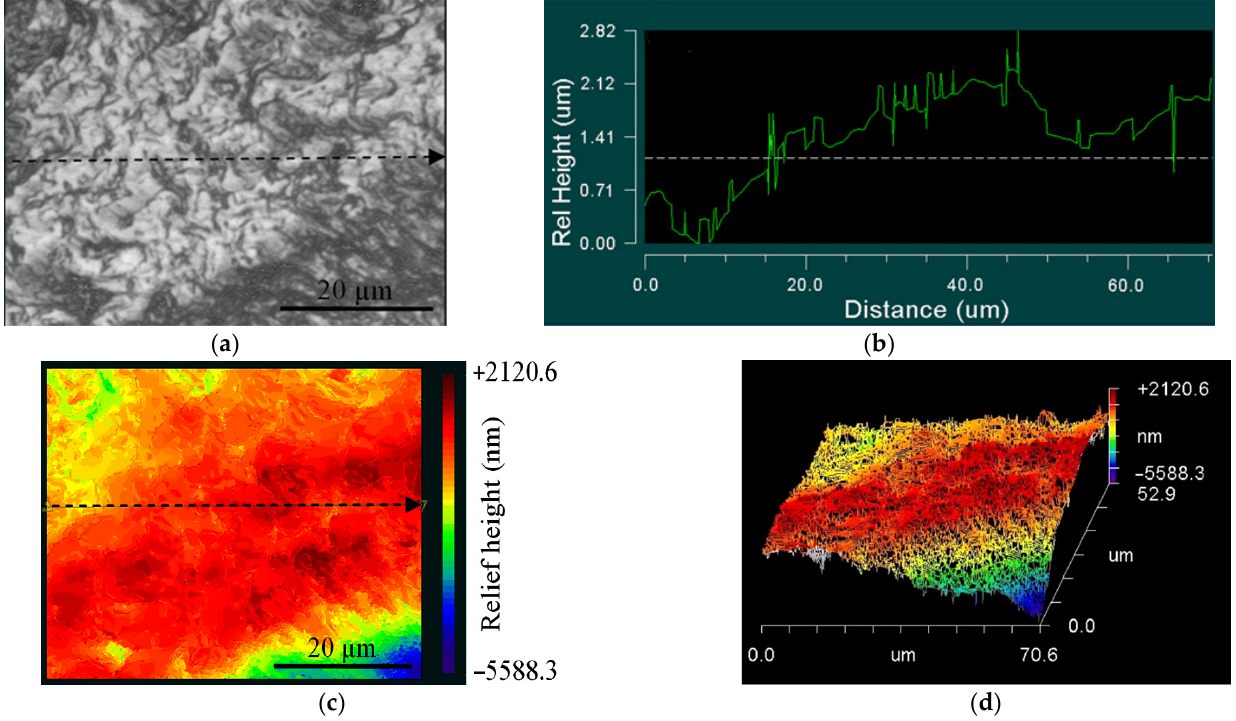
Figure 17. Image of fracture surface close to crack initiation area (zone 1) of UFG Ti-45Nb alloy: ( a ) optical image of scanning area; ( b ) one-dimensional relief map; ( c ) 2D-relief map; ( d ) 3D-relief map.